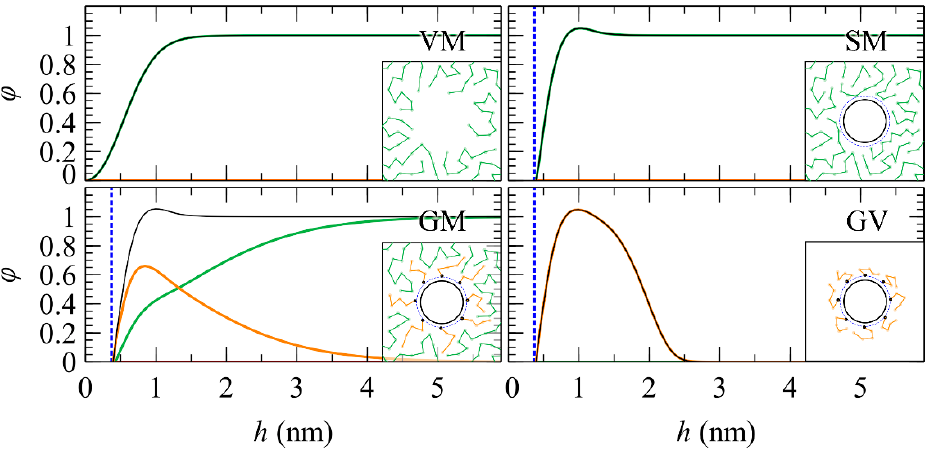
Figure 2. Same as Figure 1 but in spherical geometries. The systems are (VM) spherical cavity, (SM) a melt/smooth nanoparticle, (GM) melt/grafted nanoparticle, and (GV) a grafted nanoparticle in vacuum. In all cases, the radius of the nanoparticle/cavity is equal to 2 nm.